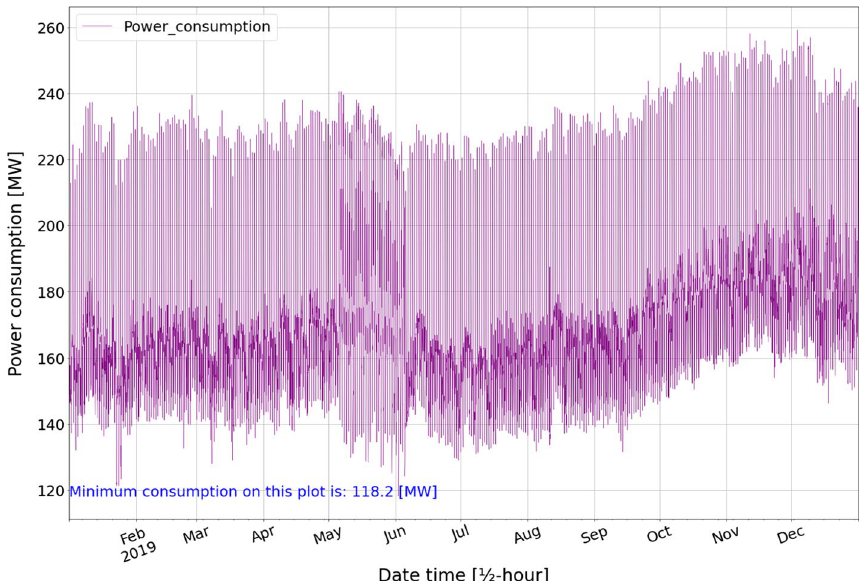
Fig. 14 ½-hourly load profile of Lombok Indonesia for the entire year of